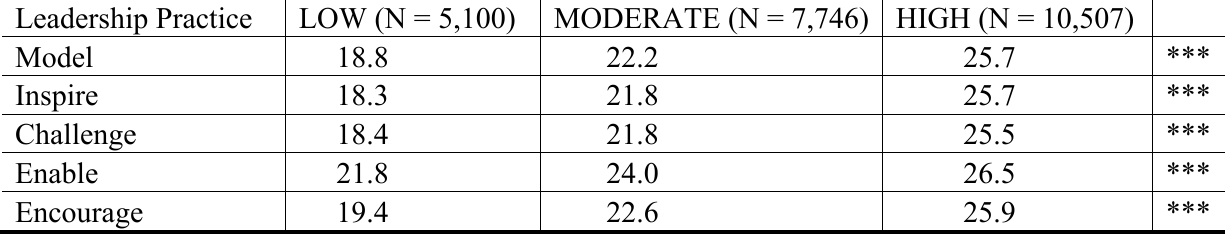
Table 10b. Comparisons by Perceived Leadership Skills